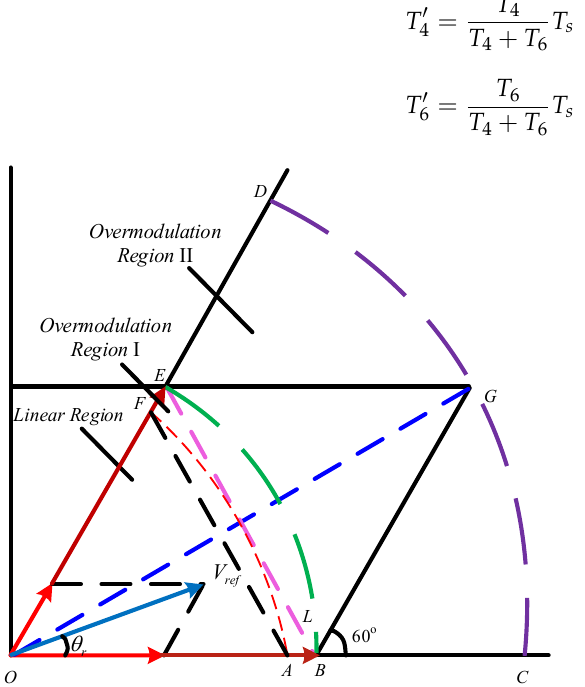
and the switching period. When T 4 + T 6 > T s and T 4 < T s , the trajectory of the reference volt- age vector was inside the isosceles triangle OBG; and when T 4 + T 6 > T s and T 4 > T s , the trajectory of the reference voltage vector was outside the isosceles triangle OBG, i.e.,